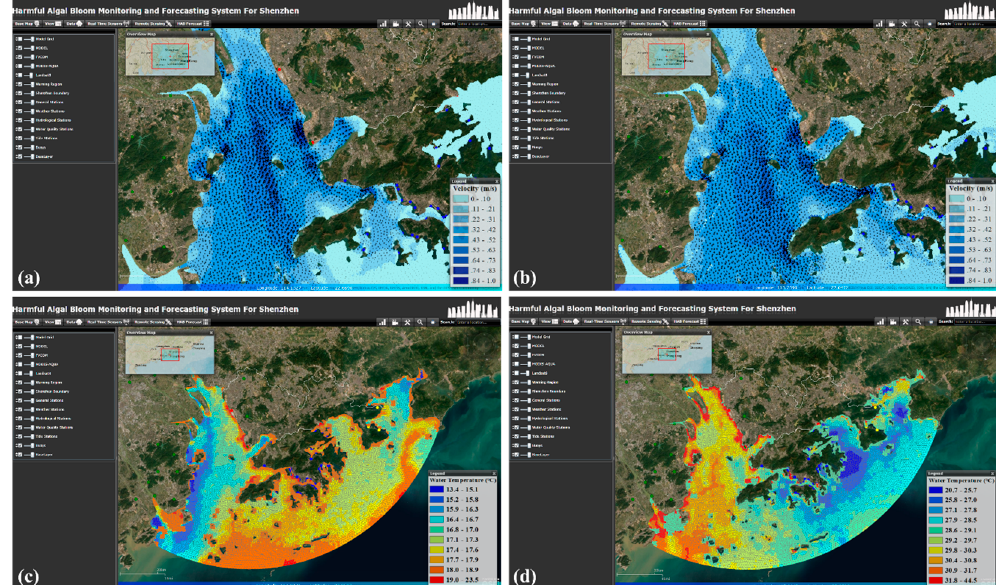
Figure 9. Visualization of simulated hydrodynamic model outputs in the web portal: Simulated sea surface current during flood tide ( a ) and ebb tide ( b ); simulated sea surface temperatures on 10 January 2018 ( c ) and 10 July 2018 ( d ).